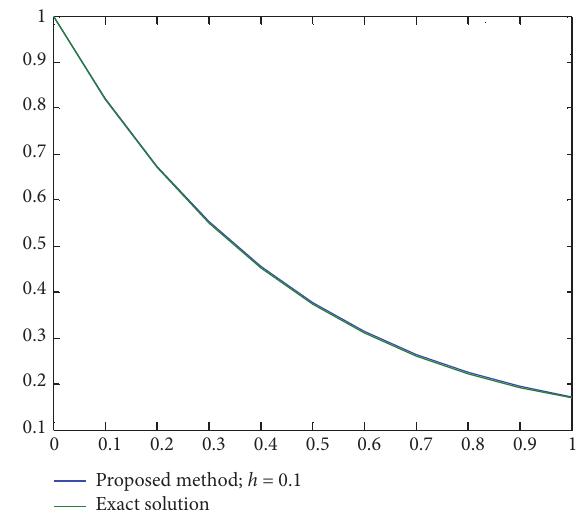
Figure 3: Numerical solutions using Heun’s method and exact solution for Example 2.